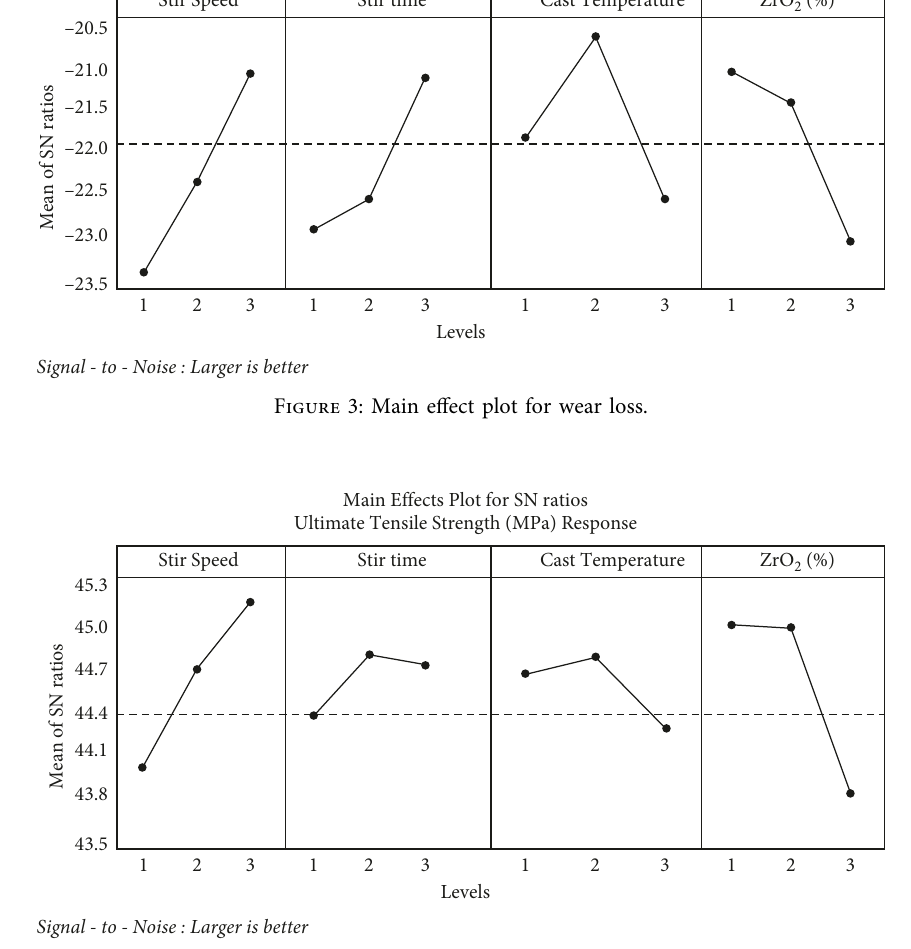
Figure 4: Main effect plot for ultimate tensile